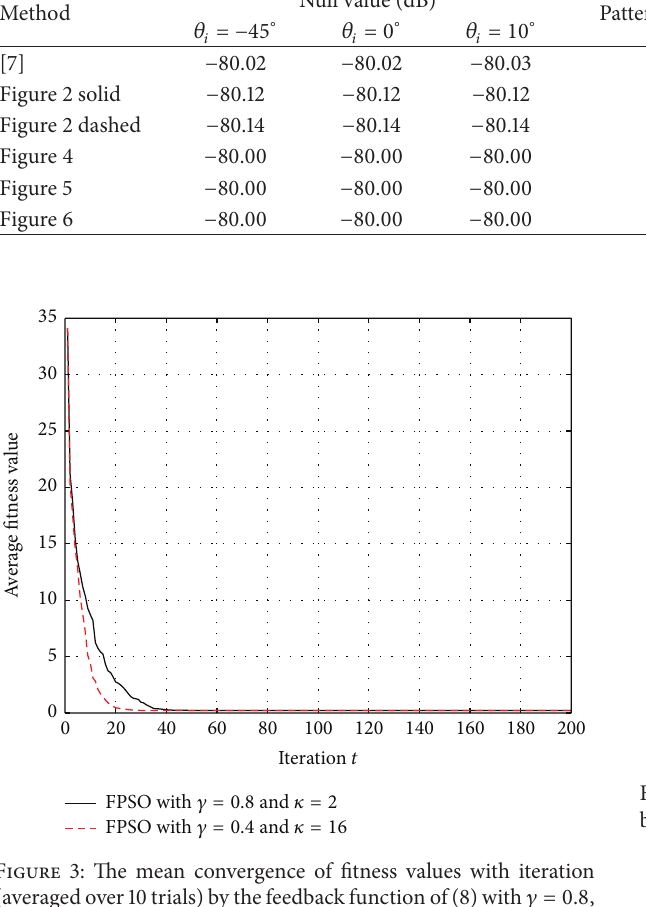
(10) with 𝑏 1 = 100 , 𝑏 2 = 1 , 𝑏 3 = 1 is proposed to simulate